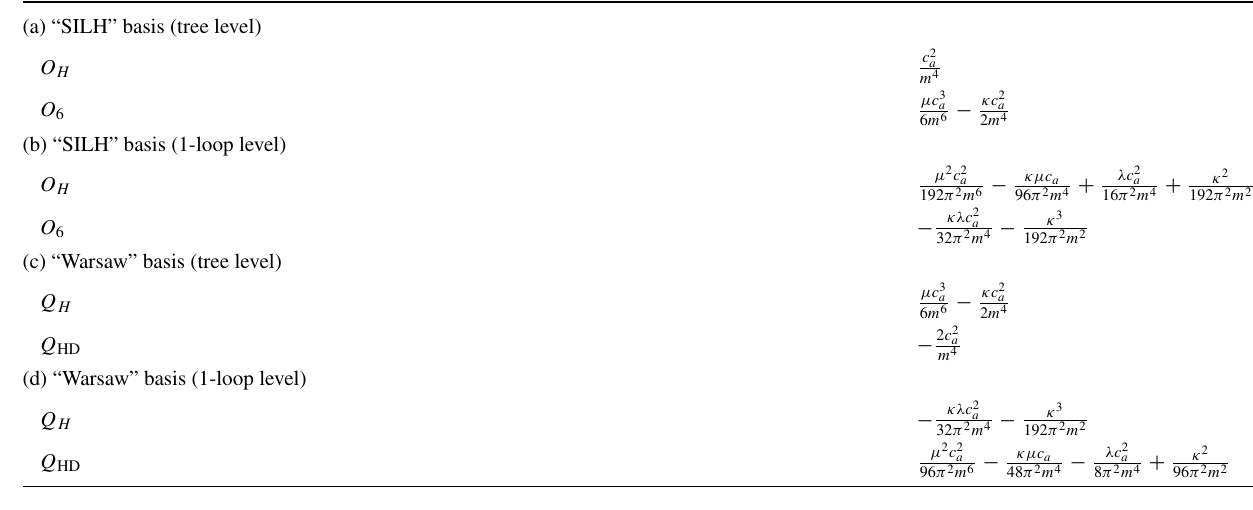
Table 6 Effective operators and Wilson coefficients for real singlet scalar. These results are calculated in the MS renormalization scheme. The 1-loop result may be altered based on the choice of renormaliza- tion scheme, e.g. in this particular case we have noted mismatches with results given in Ref. [19] where a different renormalization scheme has